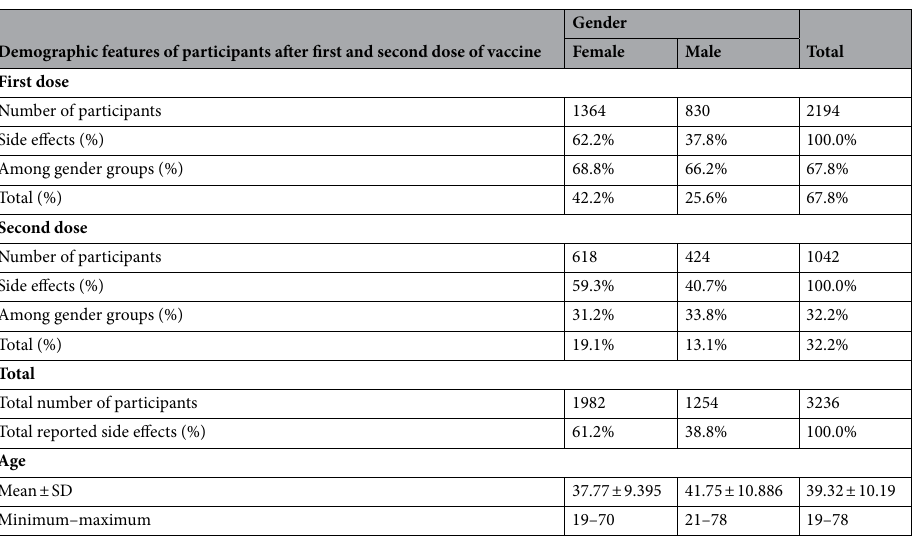
Table 1. Demographic features of participants reported side effect after first and second dose vaccination by Sputnik V COVID-19 vaccine.